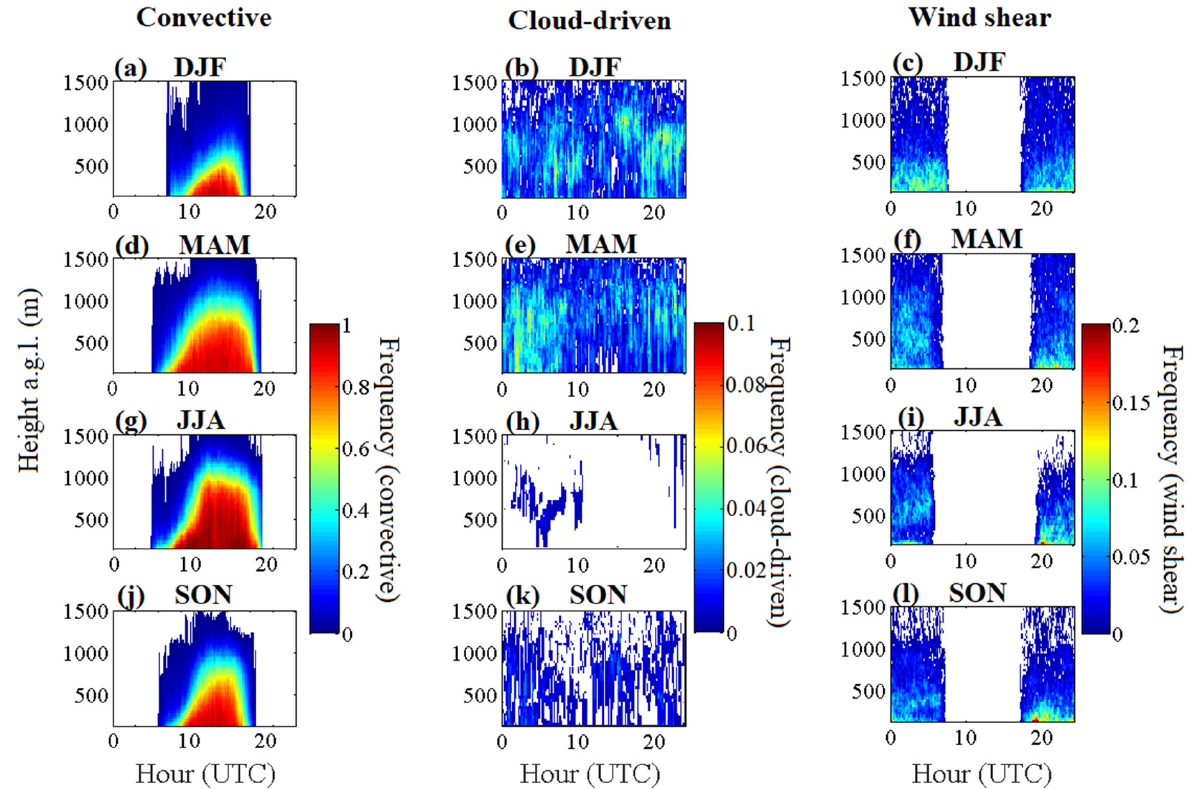
Figure 6. Frequency of occurrence of the three main labelled turbulence sources, namely convective ( a , d , g , j ), cloud-driven ( b , e , h , k ) and wind shear ( c , f , i , l ) for each time and range gates, and for each season at Granada station from 3 May 2016 to 2 May 2018.